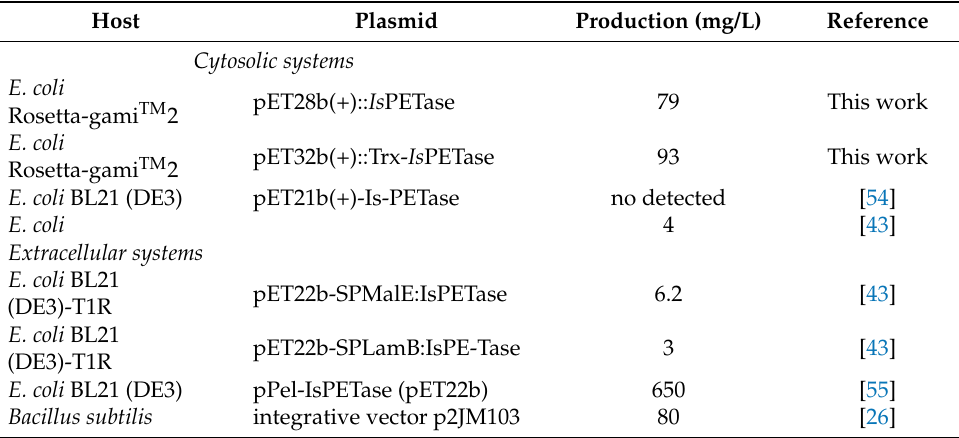
Table 1. Production of recombinant Is PETase in different systems.